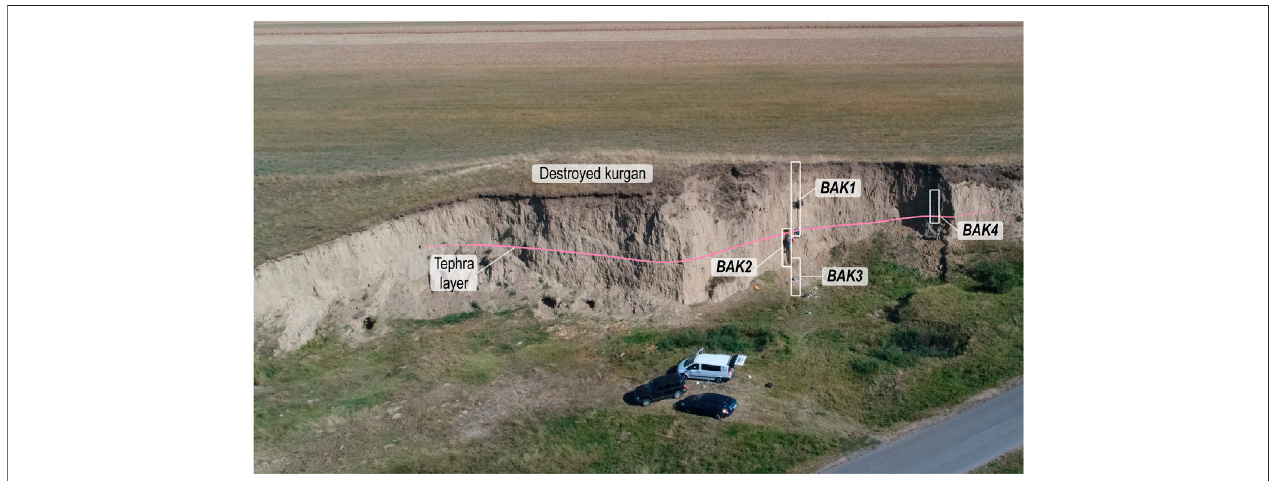
FIGURE 2| Aerial viewof the BAK site looking southeast. The location ofthe kurgan as well asthe stratigraphic position ofthe tephra layer (pink line) are indicated. The sampled sub-pro fi les are shown with white rectangles.